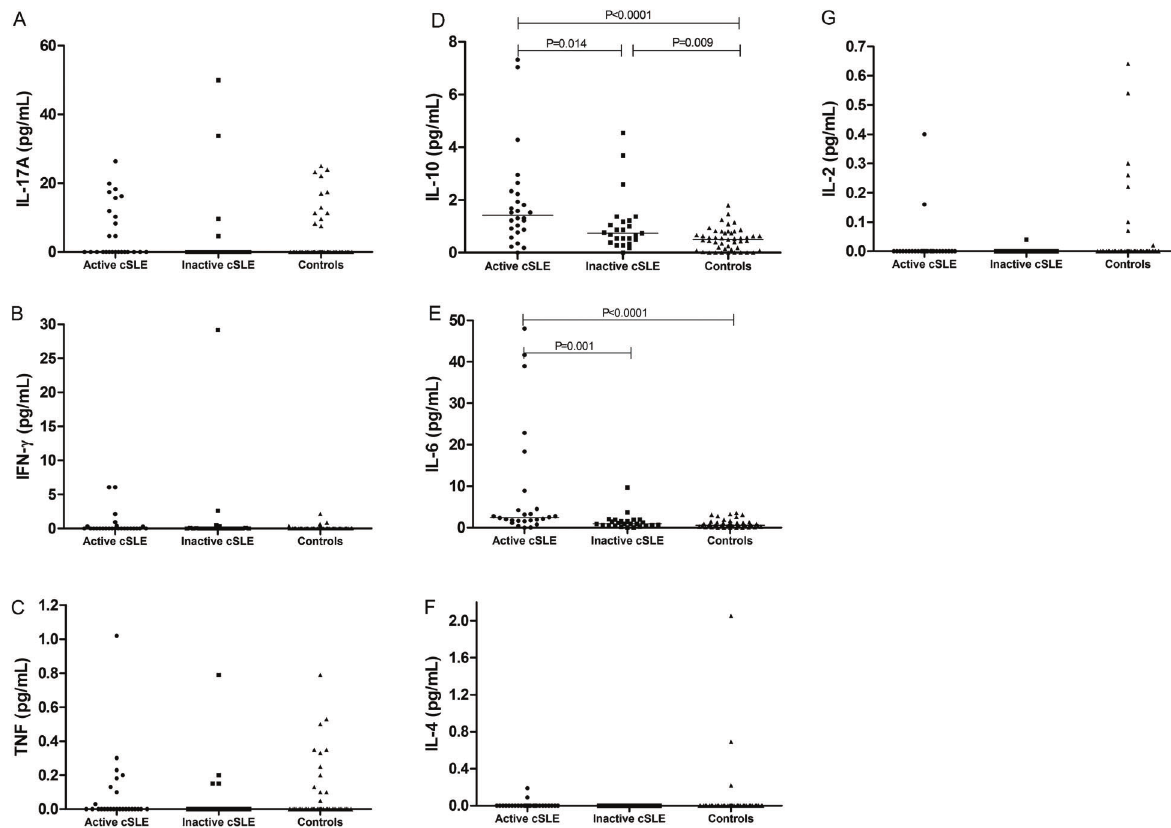
Figure 1. Th1, Th2, Th17, and Treg pro fi les of patients with active and inactive childhood-onset systemic lupus erythematosus and healthy controls. IL: interleukin; IFN: interferon; TNF: tumor necrosis factor. Data are reported as absolute values and the vertical line represents the median. Statistical analysis was done with the Kruskal-Wallis test followed by the Mann-Whitney